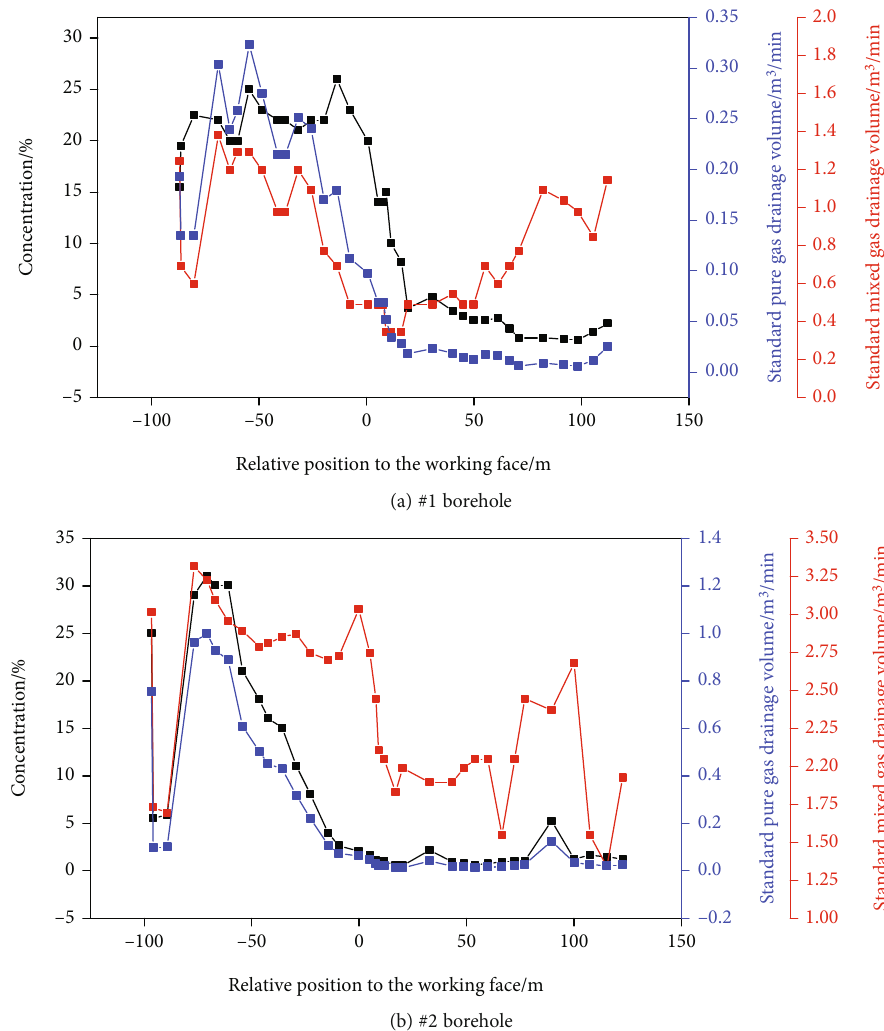
Figure 8: Statistics of the gas drainage data